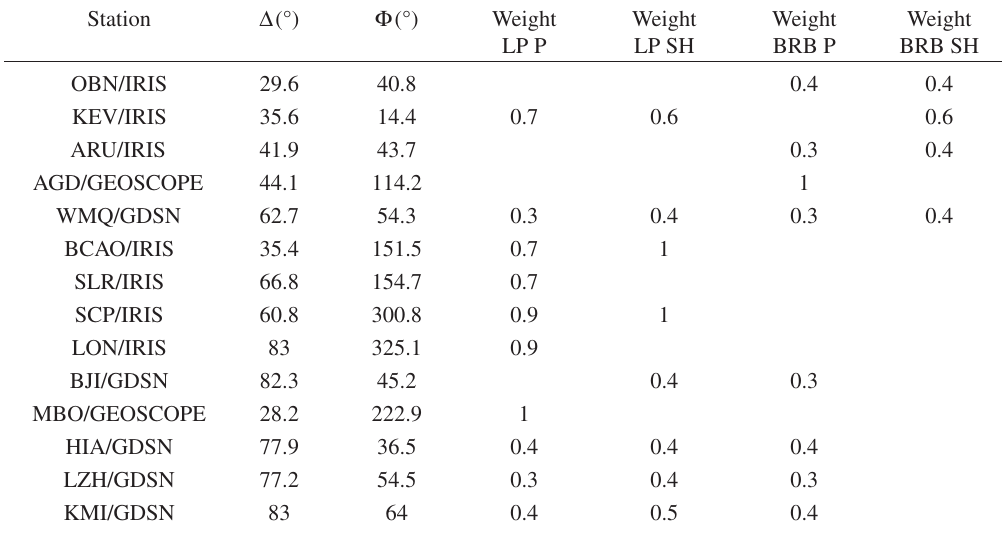
Table I. List of the stations used in the inversion procedure steps I. D and F are, respectively, epicentral distance and azimuth of the